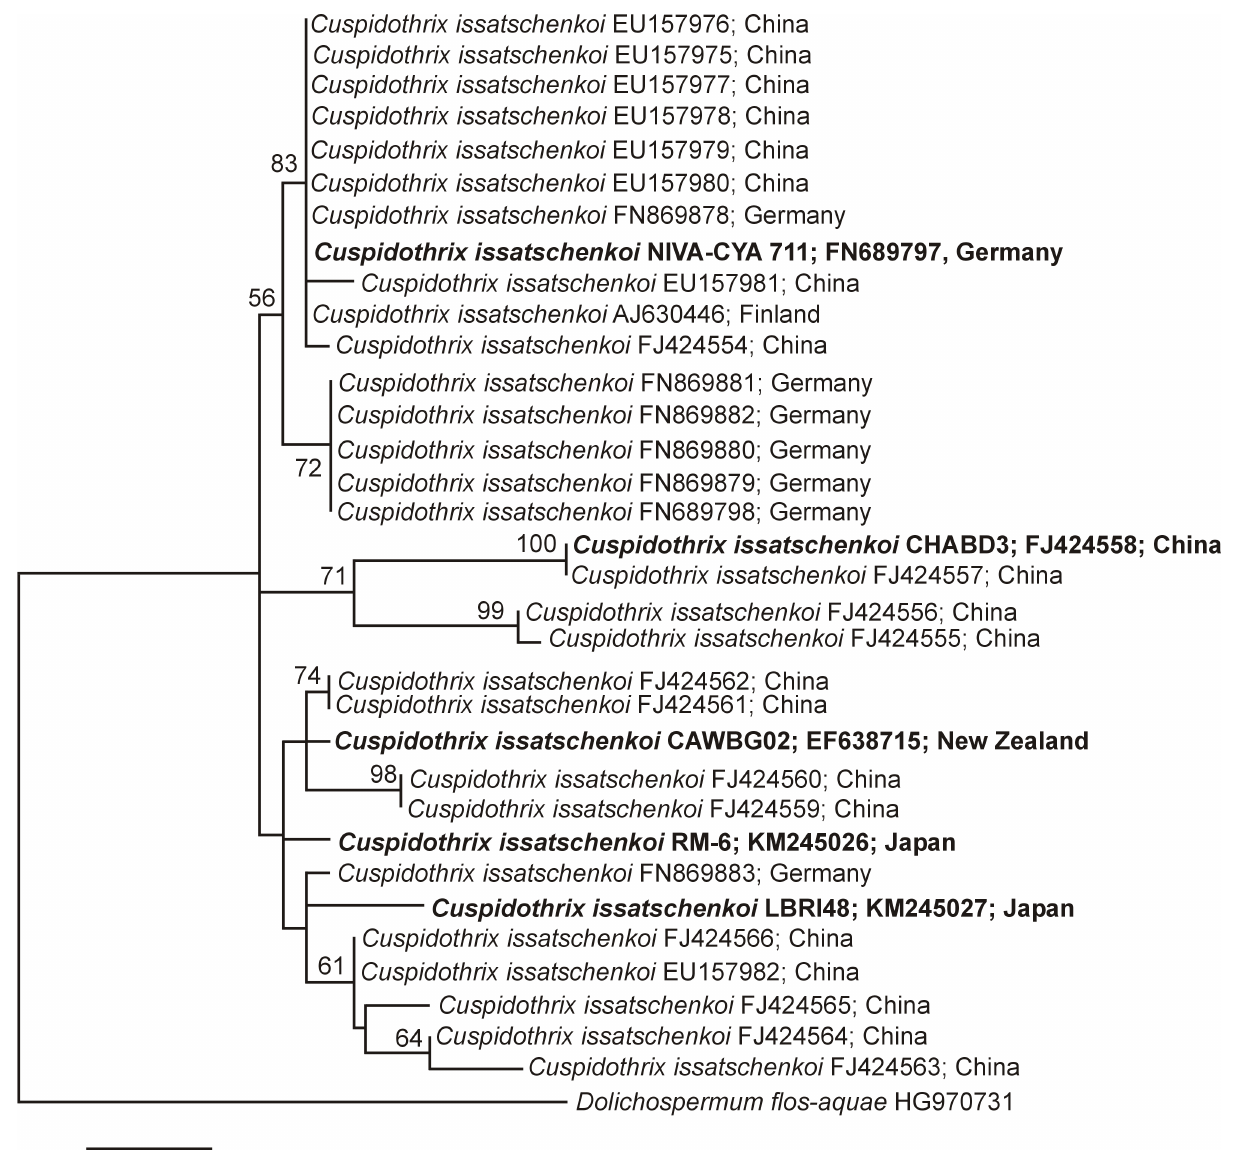
Fig 1. Maximum Likelihood tree of the 16S rRNA gene of Cuspidothrixissatschenkoi . Strains from this study are marked in bold. Bootstrap values above 50 are included. The scale bar indicates 0.5% sequence divergence.